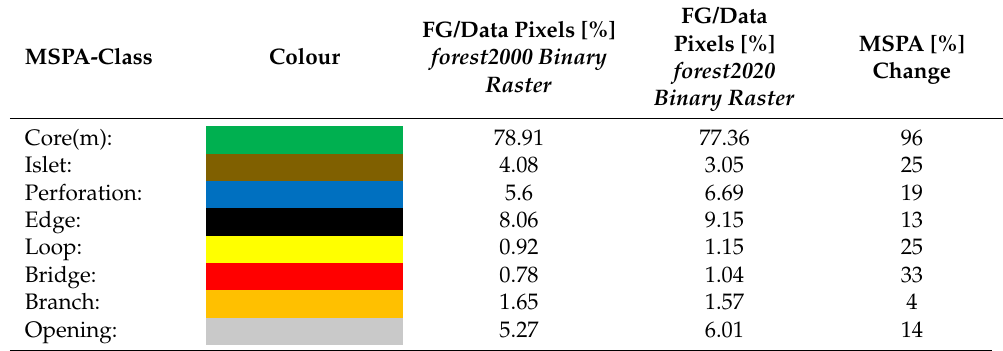
Table 9. Change in MSPA-class layers (2000–2020) for Kakamega Forest